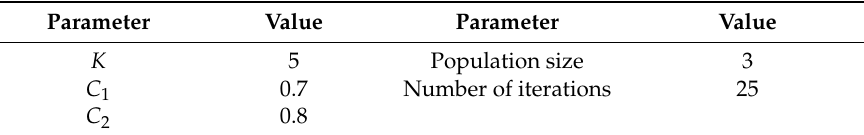
Table 4. Parameters of the RMO optimizer and their